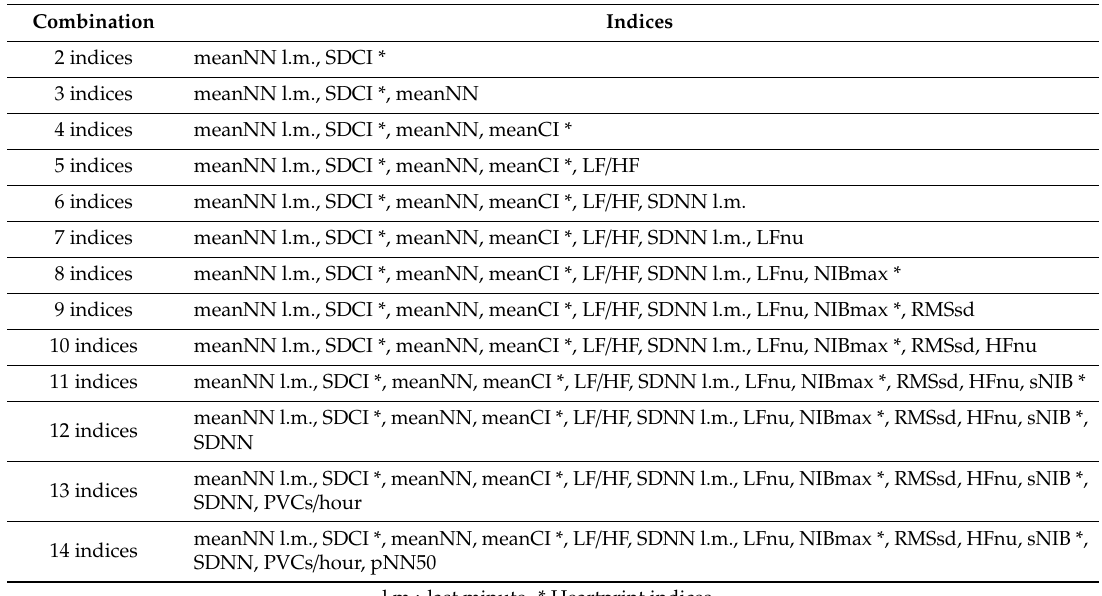
Table 3. Combination of indices for the support vector machine.